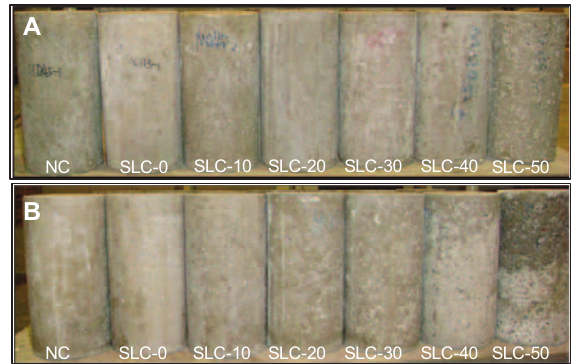
Figure 10 Pictures of “ sandless ” concrete after sulfate attacks with w/c of (A) 0.45, and (B)